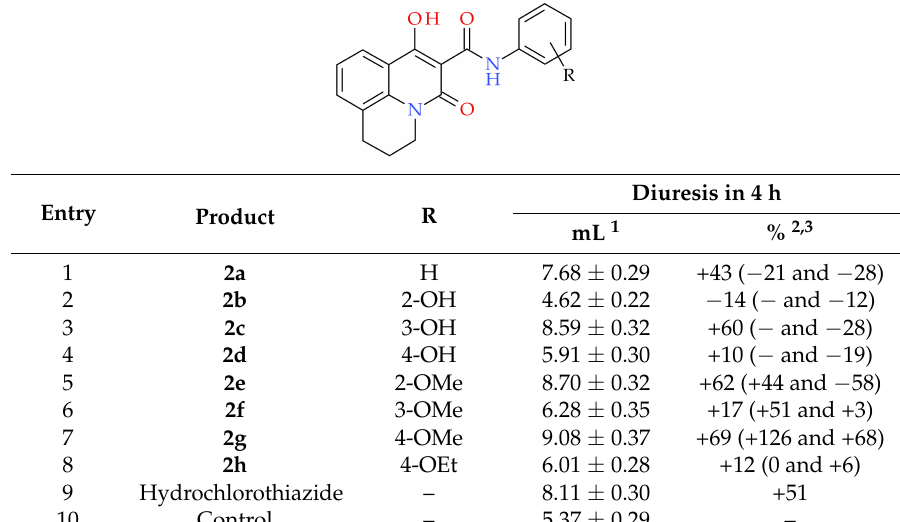
Table 1. The diuretic activity of anilides 2a – h , their corresponding pyrroloquinoline analogs VI and VII , and